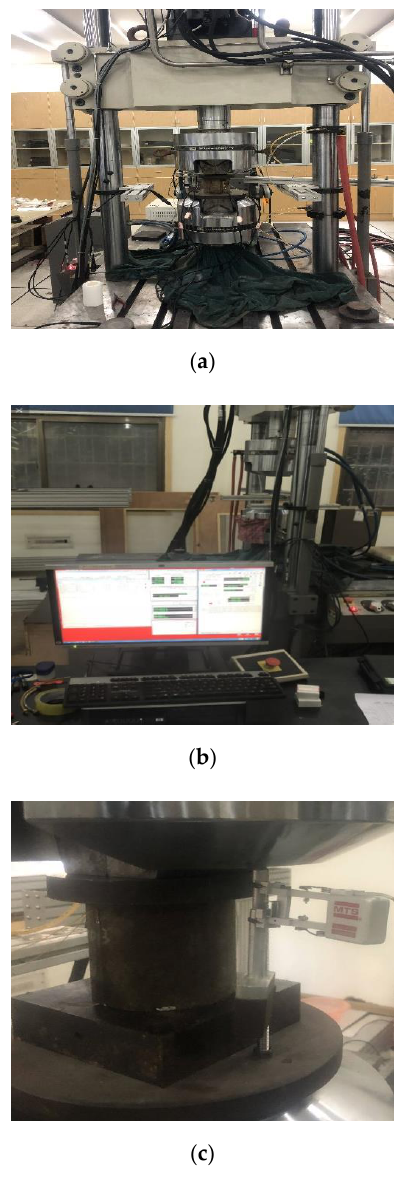
Figure 2. The uniaxial compressive test machine and control system for CA mortar: ( a ) MTS322-T type machine; ( b ) The closed-loop control system; ( c ) The setup of extensometer